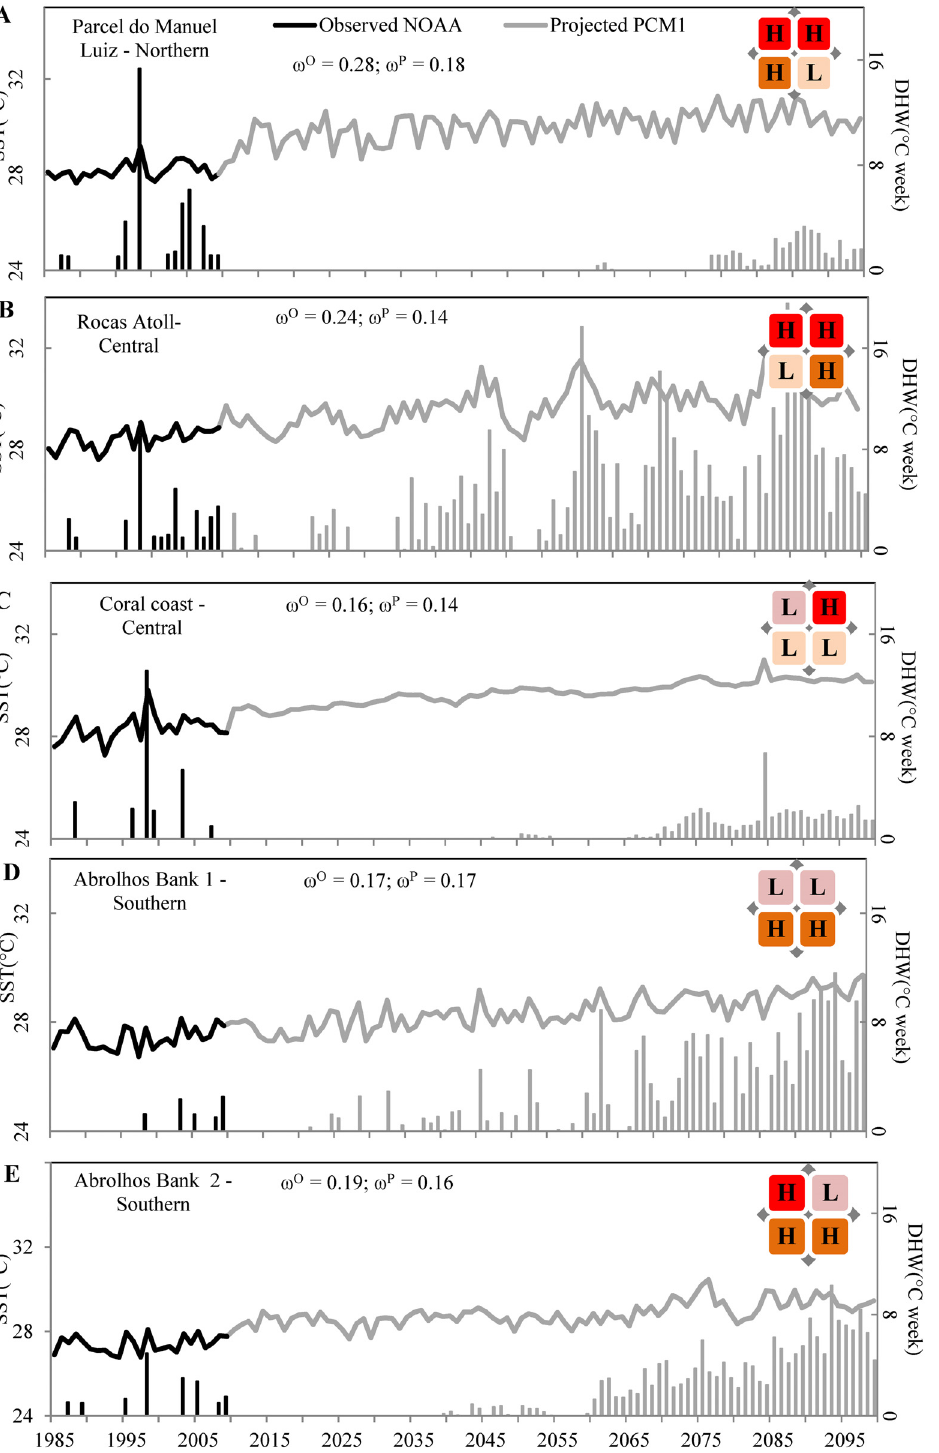
Fig 6. Annual maximum SST and Degree Heating Weeks (DHWs) for five reef cells within different thermal-stress regimes. Approximate locations of the five cells are shown as a-e in Fig 2A. Observed data (satellite NOAA) are shown by black solid lines (SST values) and filled bars (DHWs) while projections (GCM PCM1 output) are shown by gray solid lines (SST values) and filled bars (DHWs). Warming trends (in °C per decade) are shown for observed ( ɷ O ) and projected ( ɷ P ) time series. The thermal-stress regime allocated to each reef cell is indicated in the top right of each graph, and defined in Fig 3.